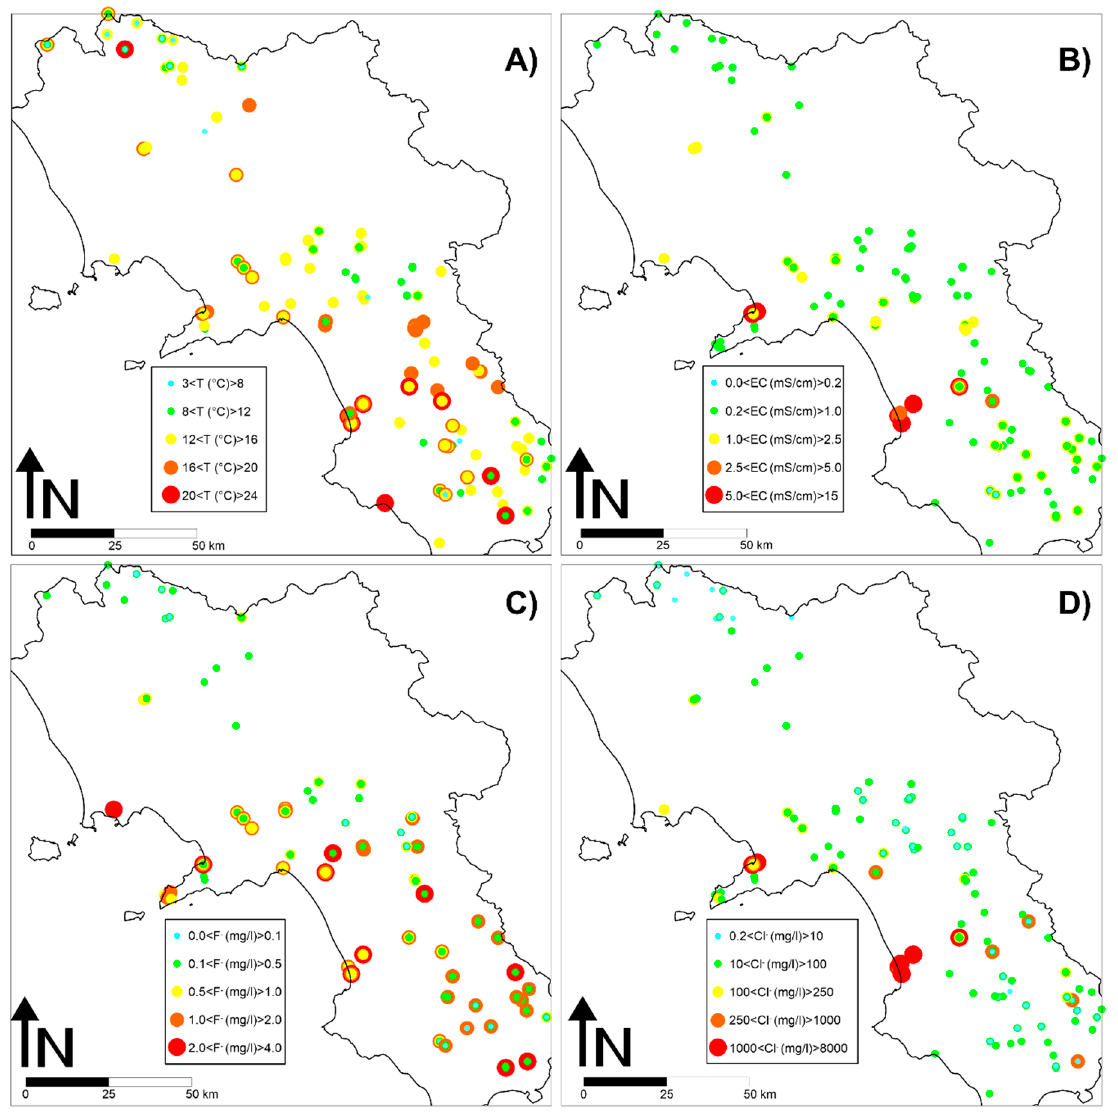
Figure 3. ( A ) Map of all the available spring water temperatures. ( B ) Map of all the available spring water electrical conductivity (EC) values. ( C ) Map of all the available spring water F − concentrations. ( D ) Map of all the available spring water Cl − concentrations.